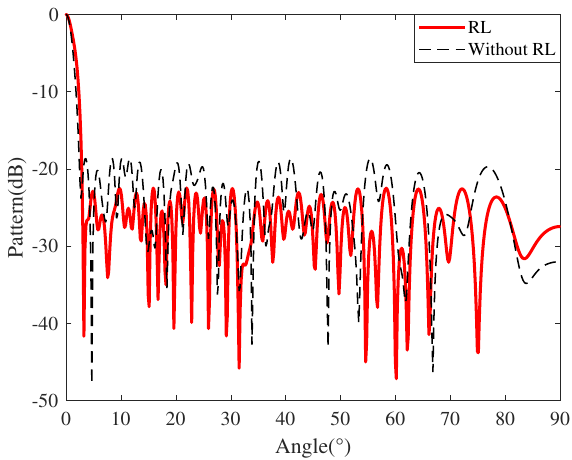
Figure 9. Beampatterns with and without RL.